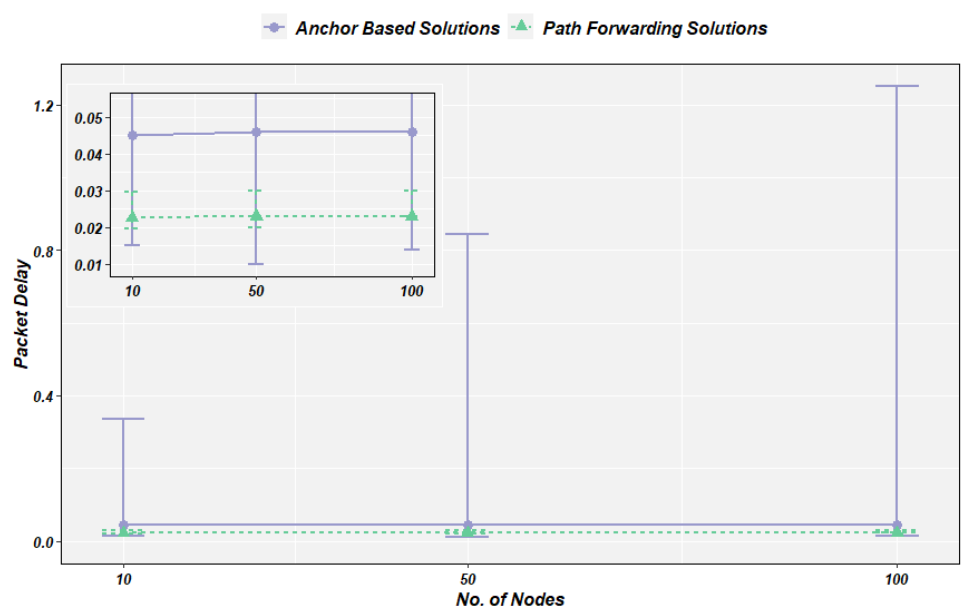
Figure 7. End-to-end packet delay in Path Forwarding vs Anchor Based Networks showing mean and maximum/minimum